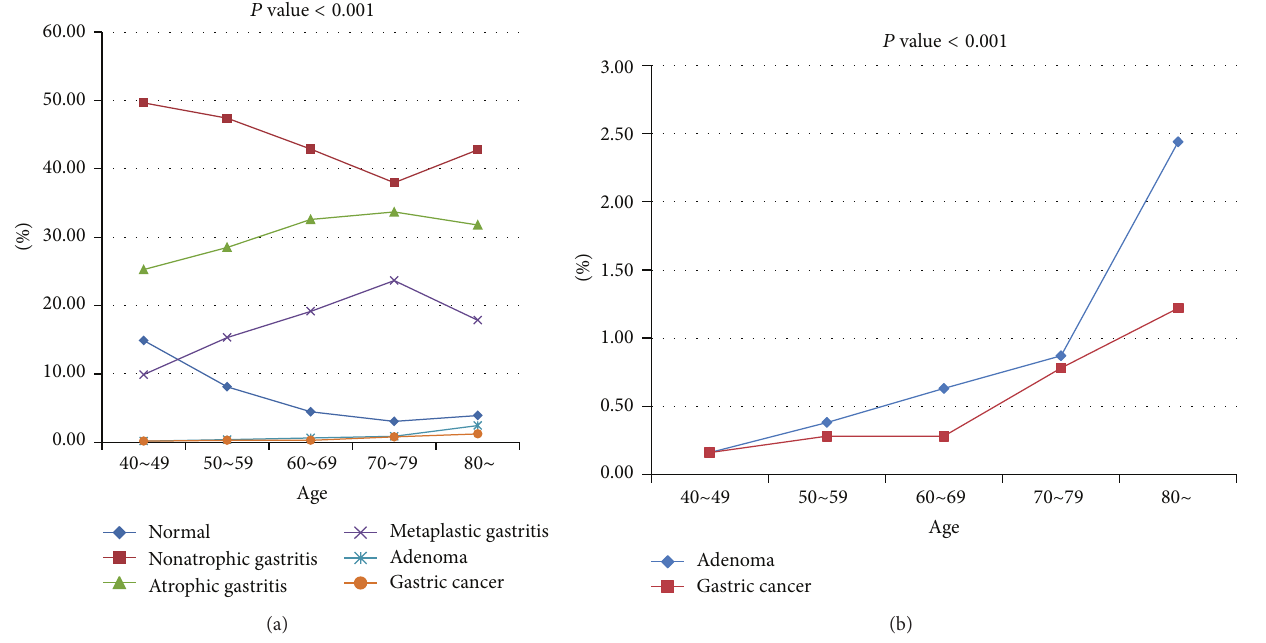
Figure 2: (a) Prevalence of gastric disease according to age distribution. (b) Prevalence of adenoma and gastric cancer according to age distribution.